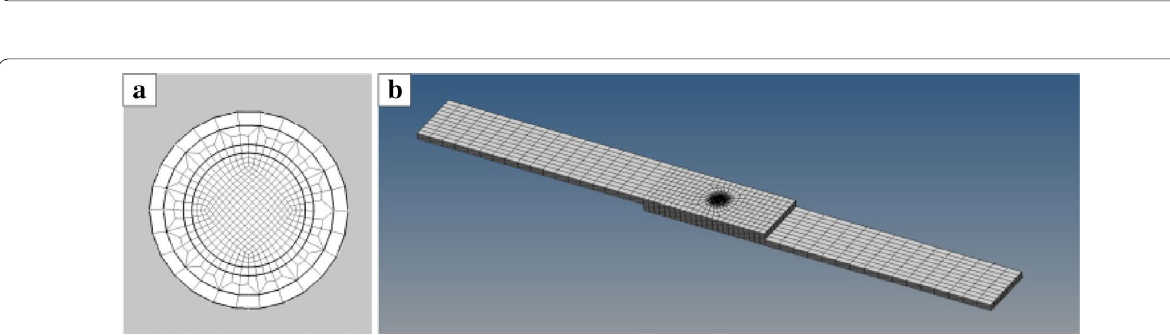
Figure 8 Comparison of weld morphology of welded joints: a Numerical simulation of the molten pool morphology; b Actual weld joint morphology